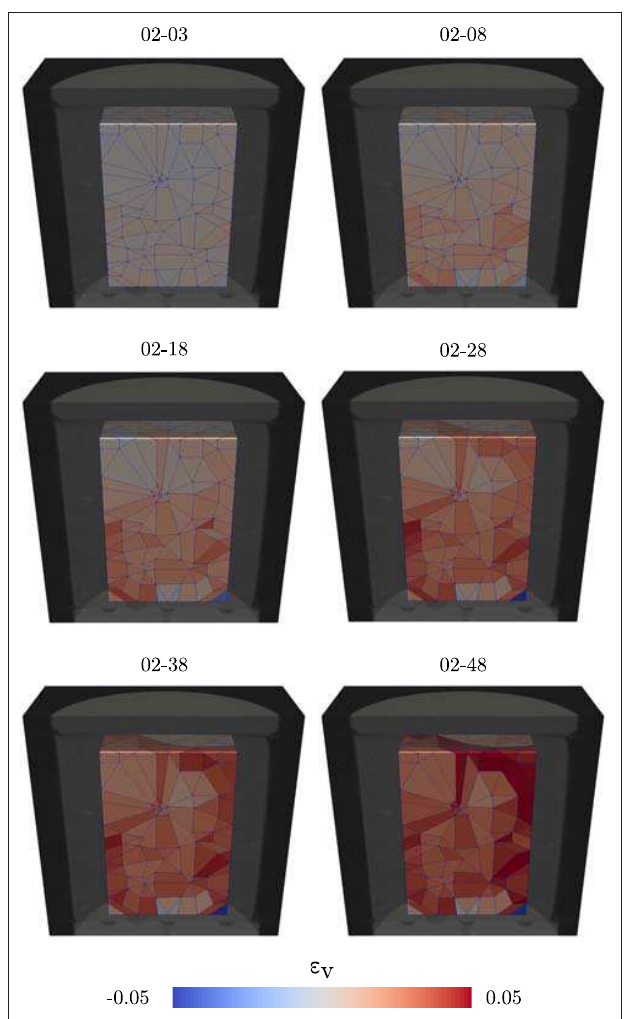
FIGURE 9 | Semi-transparent rendering of the x-ray graylevels of specimen (state 002) with the mesh used for the total global correlation with tetrahedra colored by their volumetric strain. Using Equation (12) and its assumptions, the color bar for ε v corresponds to δ(cid:127) w δ(cid:127)